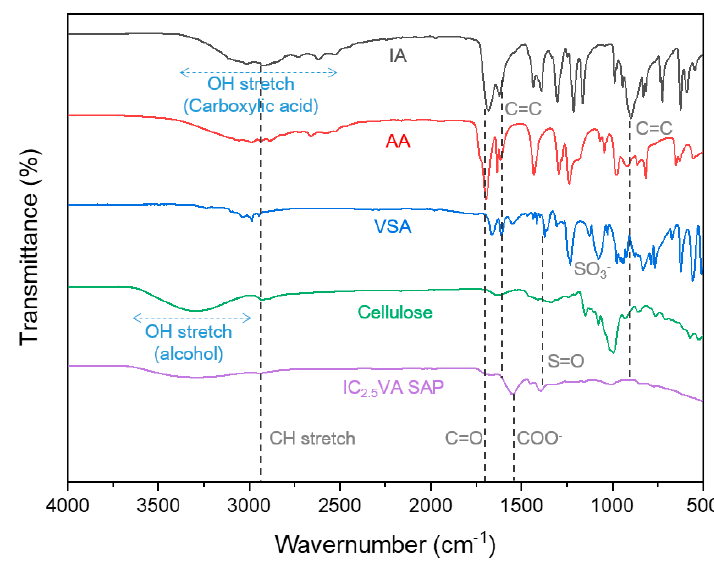
Figure 2. FT-IR spectra of IA, cellulose, VSA, AA, and IC 2.5 VA CSAP.